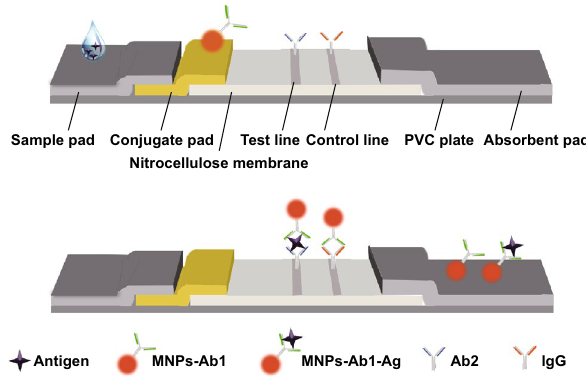
Fig. 1 Format and assay principle of